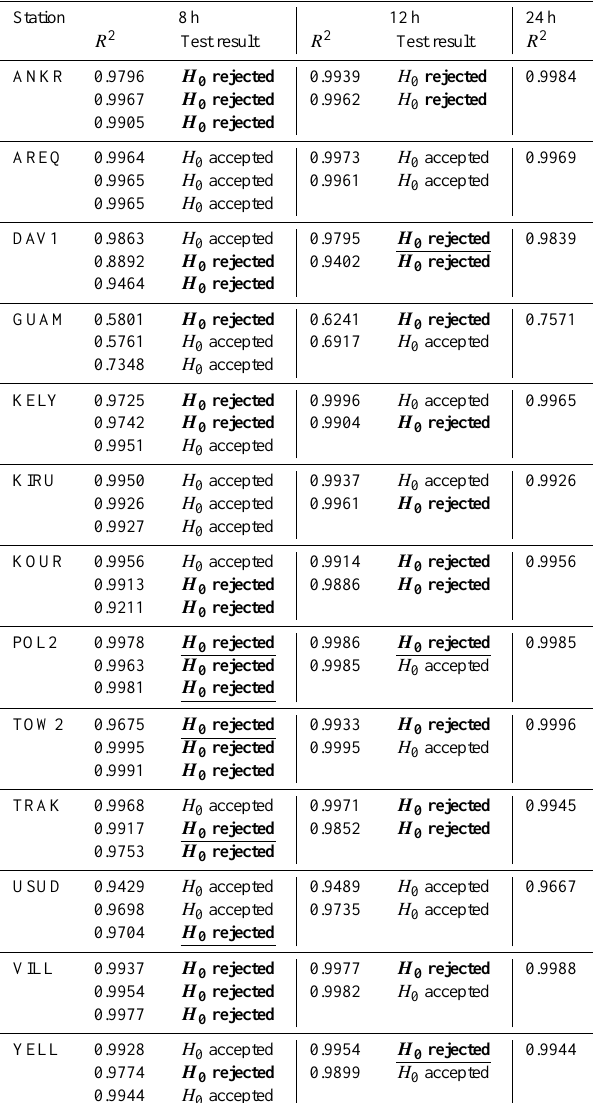
Table 2. Hypothesis testing results for latitude: rejections indicated in bold-faced letters are related to an F test; rejections indicated in underlined bold-faced letters are from Student’s t test; the stations with R 2 values smaller than 0.99 are not used in the evaluation.